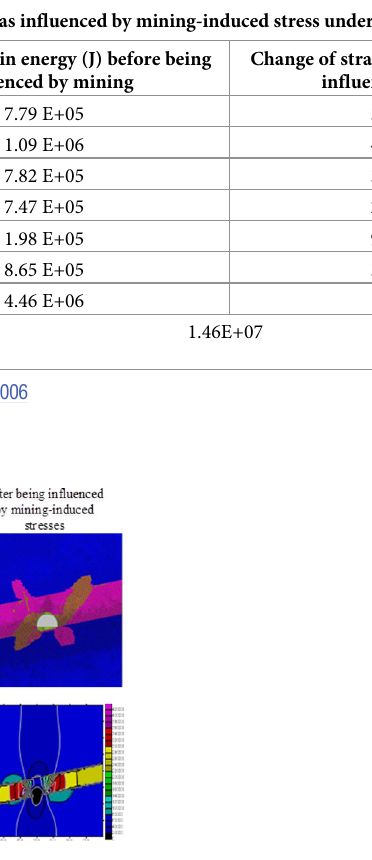
Fig 13. The shape changes before and after the plastic zone and the distribution of energy contours under mining stress.